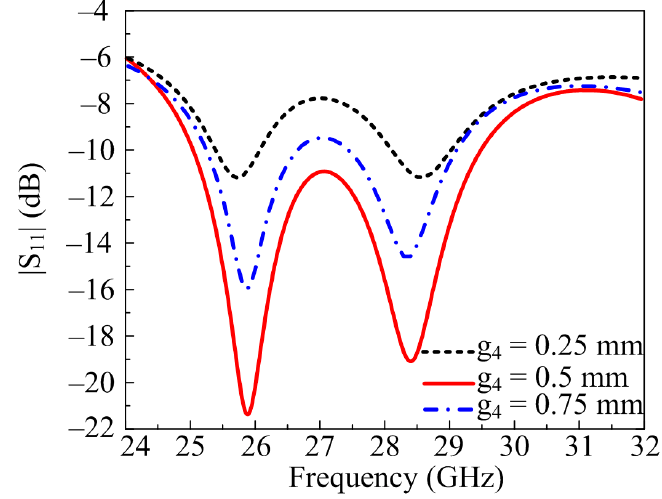
Figure 4. Parametric study of the extended feed width